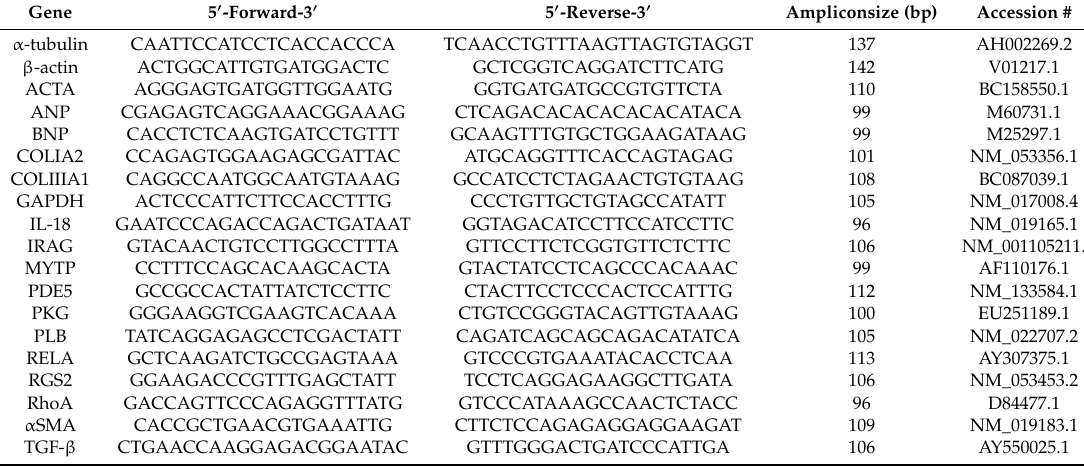
Table 1. Oligonucleotides used for study of the MIT copy